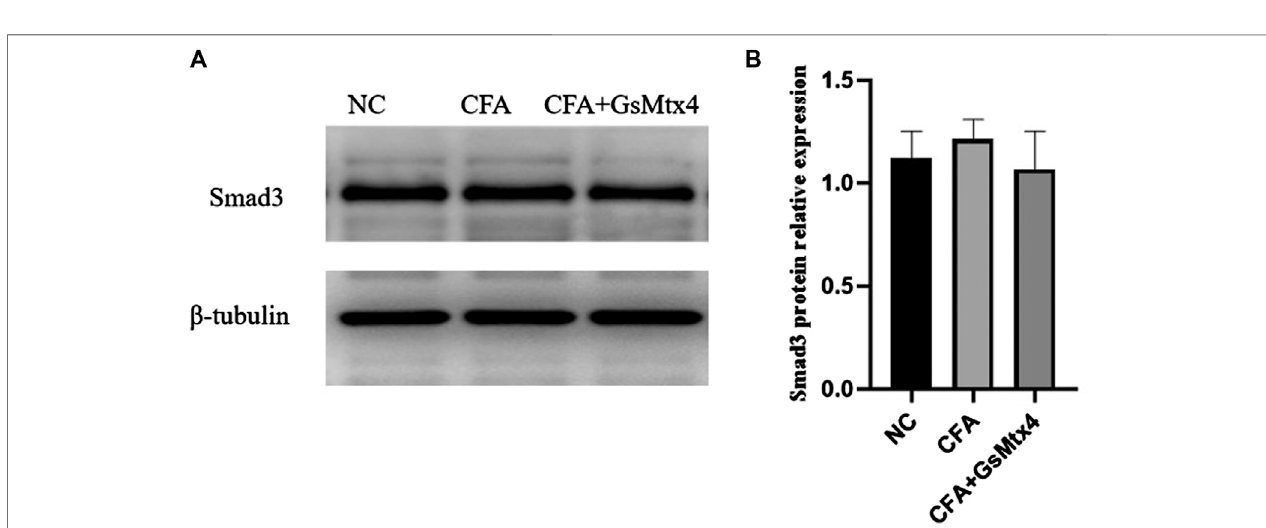
FIGURE 8 | (A) Smad3 expression in each group; (B) Statistical analysis of the Smad3 expression in each